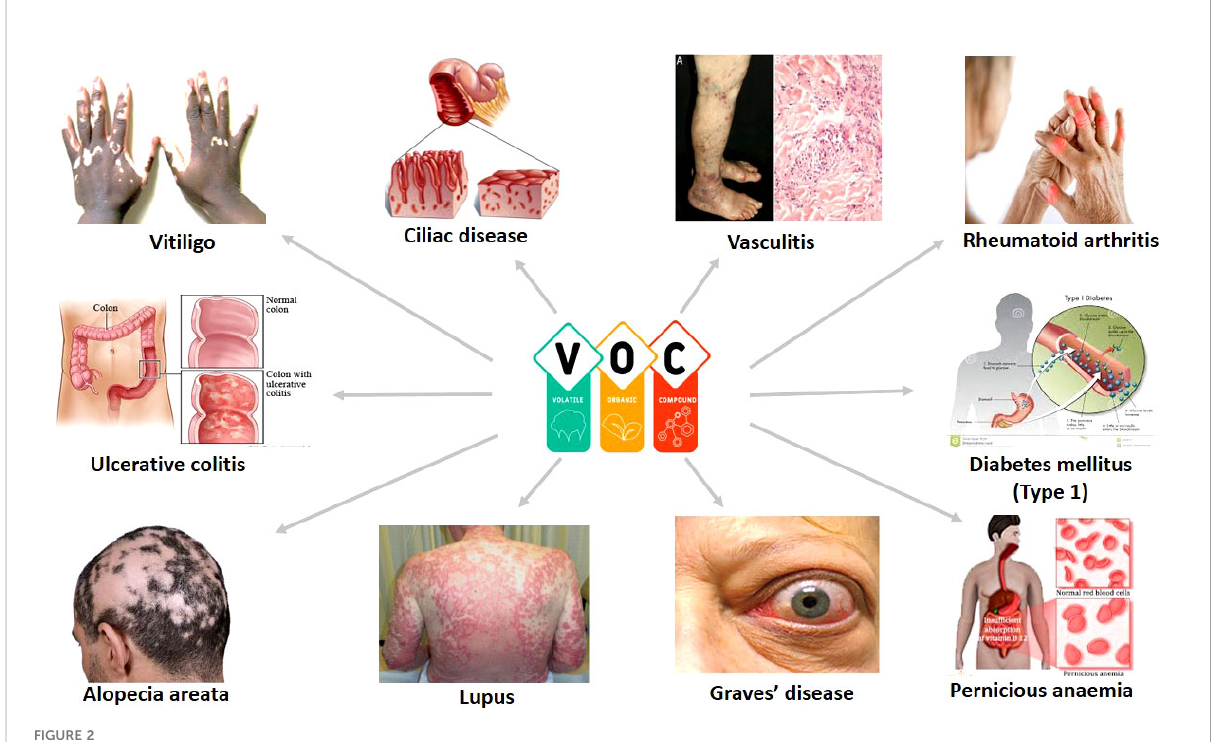
FIGURE 2 Common autoimmune diseases associated with VOC